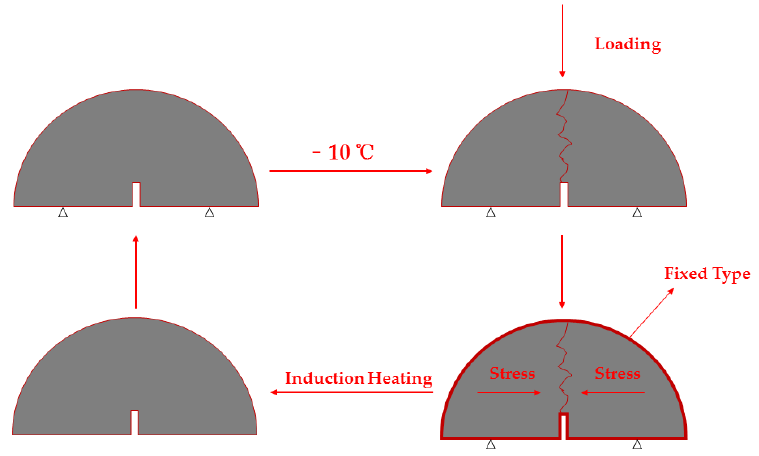
Figure 5. Fatigue-Healing-Fatigue test. Figure 5 Fatigue-Healing-Fatigue test.